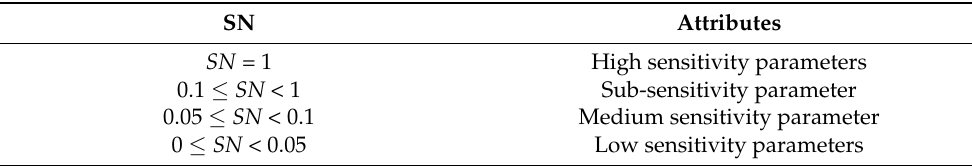
Table 3. The attributes of the sensitivity